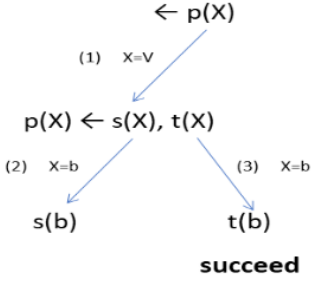
Figure 2. Evaluation tree #2.